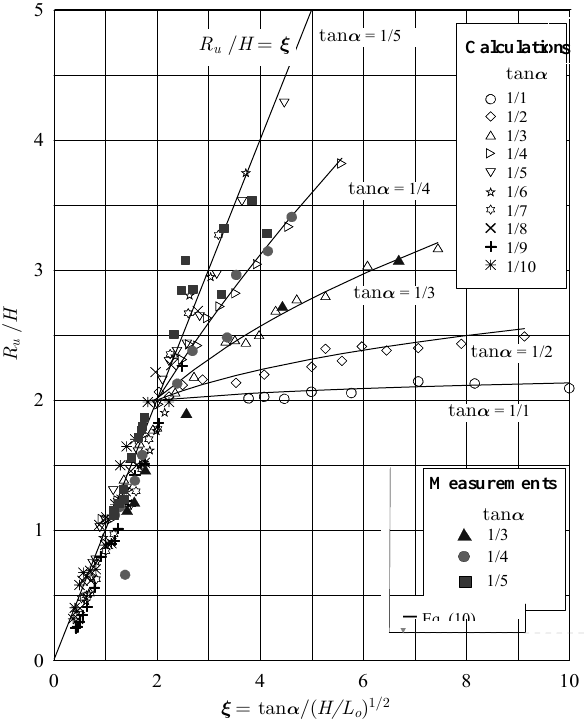
Figure 7. Wave run-up height versus Iribarren number  for regular wave transformation on 2 Fig. 7. Wave run-up height versus Iribarren number ξ for regular wave transformation on various uniform slopes; the branch point at various uniform slopes; the beanch point at  can also be seen. 3 ξ can also be